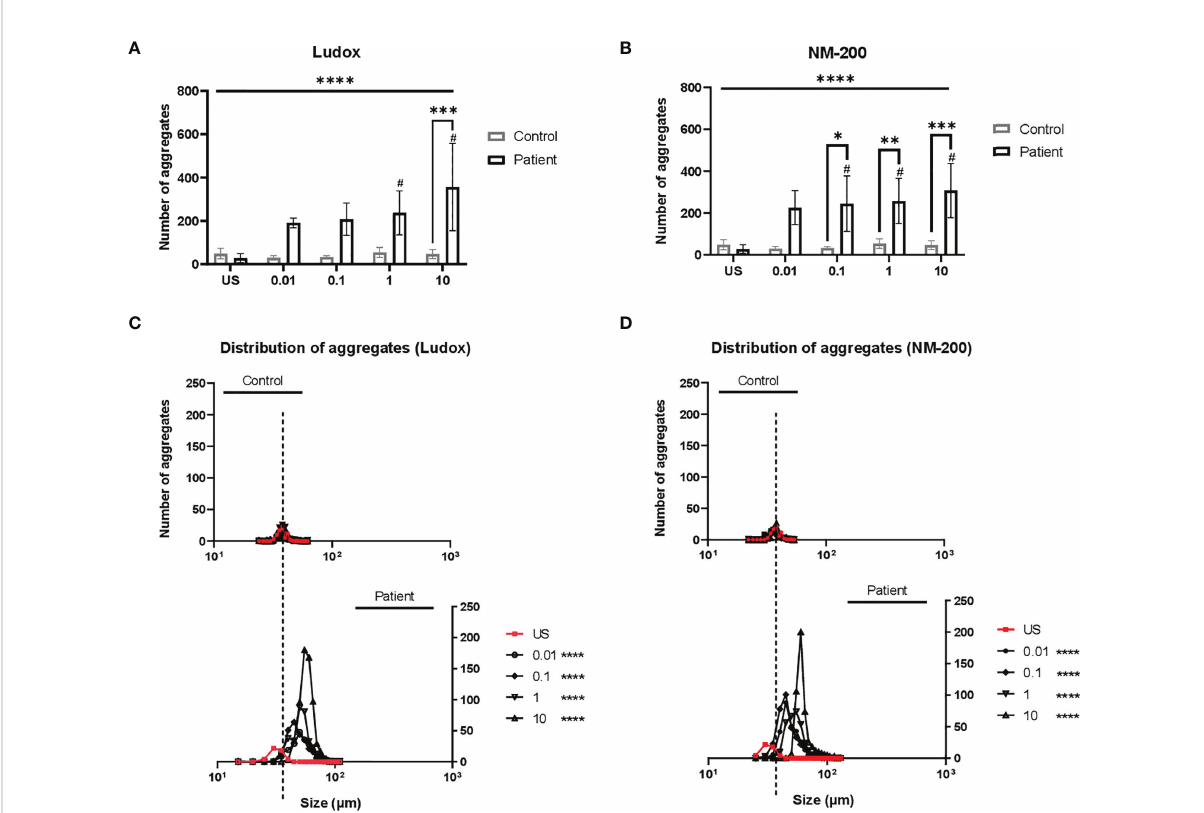
FIGURE 4 (A – D) Distribution of aggregates in patients from controls. On day 7, the diameter (µm) and number of aggregates were measured and counted across two replicates. The mean number of aggregates at concentrations 0.01 to 10 µg/ml of Ludox (A) and NM-200 (B) within patients were compared with the controls. Differences in frequency distribution (accounts for size and number of aggregates) were additionally compared between silicotic patients and controls at all exposure conditions for Ludox (C) and NM-200 (D) . Tukey ’ s multiple comparisons tests via two-way ANOVA was performed to determine signi fi cance in number of aggregates across SiNP concentrations against unstimulated condition within each subject group, # signi fi cant at p < 0.05 and between the two groups of subjects per exposure condition; *p < 0.05, **p < 0.01 and ***p < 0.001. ANOVA F-tests or level of signi fi cance between both groups regardless of exposure conditions are denoted by ****p < 0.0001. Kruskal-Wallis test via one-way ANOVA test was performed to determine signi fi cance in distribution of aggregates per pair of concentrations and between both groups with signi fi cance